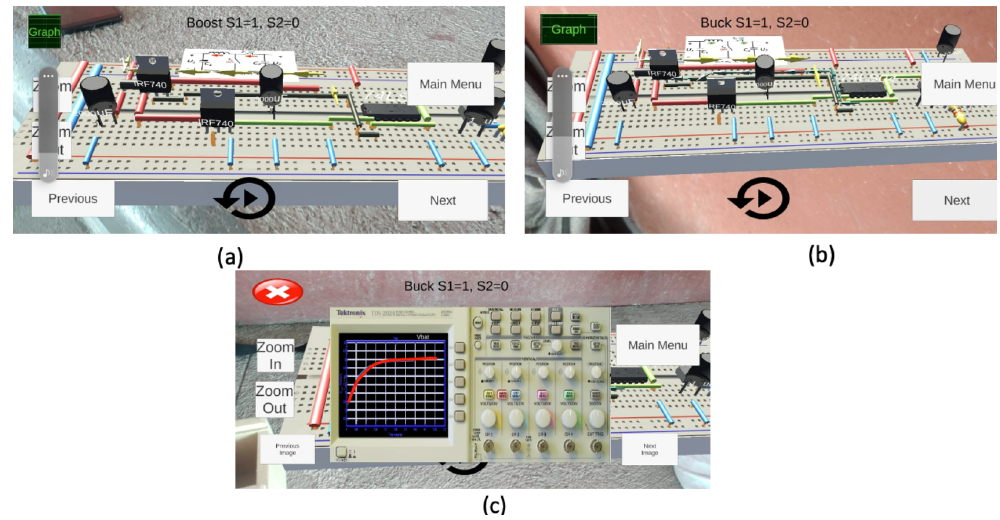
Figure 9. AR GUI to assemble the Buck/Boost converter. ( a ) Connecting guide for Buck; ( b ) Assembly help for Boost; ( c ) Using an oscilloscope to measure the voltage of the batteries.